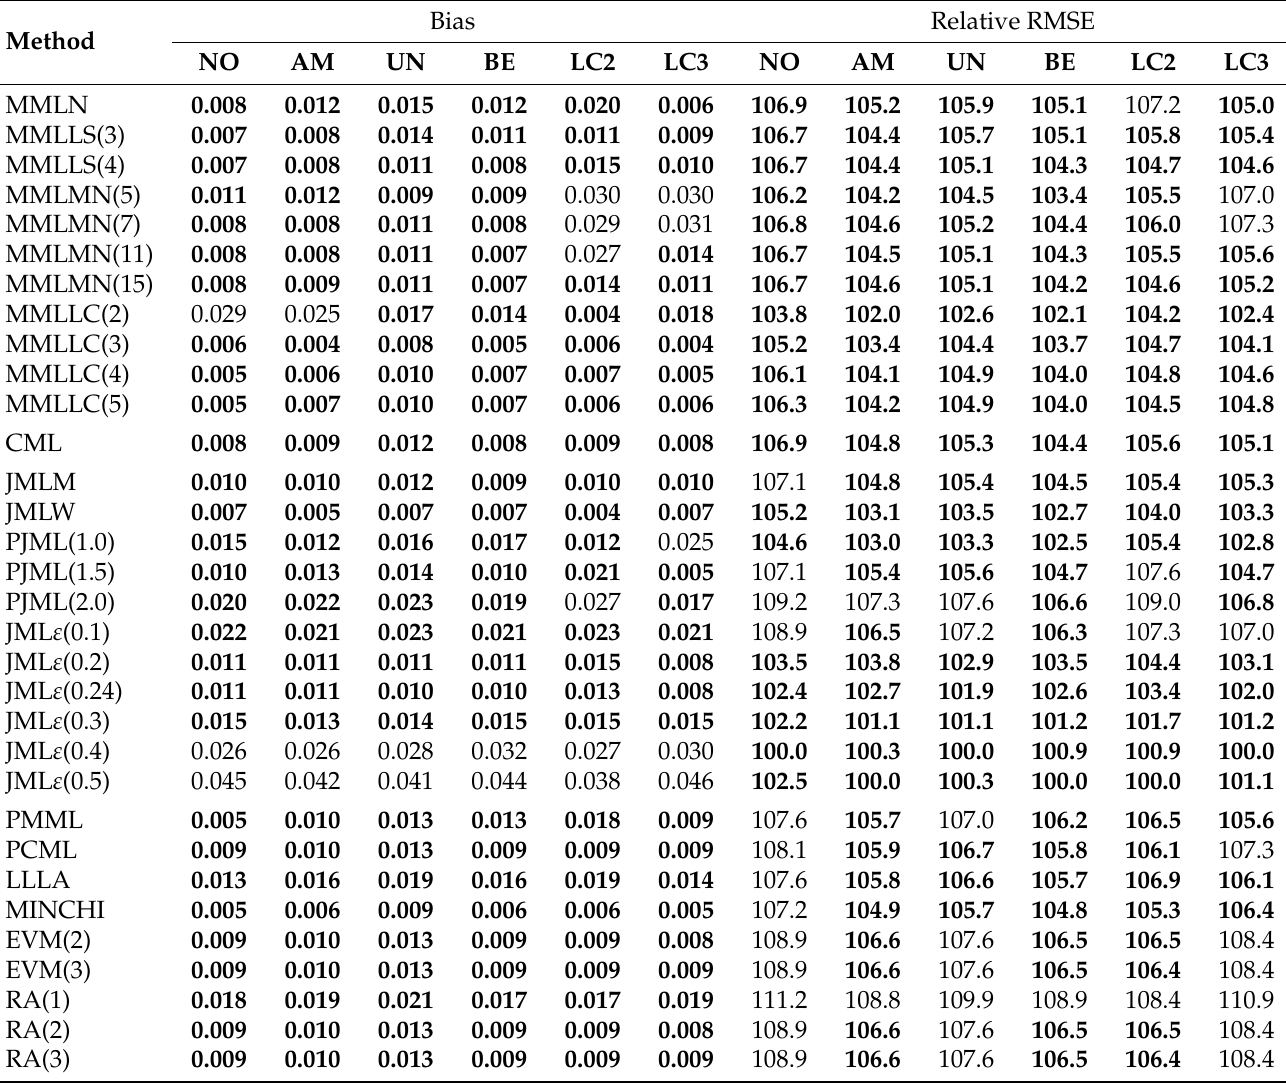
Table 4. Bias and relative RMSE for different estimation methods for a sample size of N = 250 and I = 30 items for a test with a wide range of symmetrically distributed item difficulties as a function of the data-generating trait